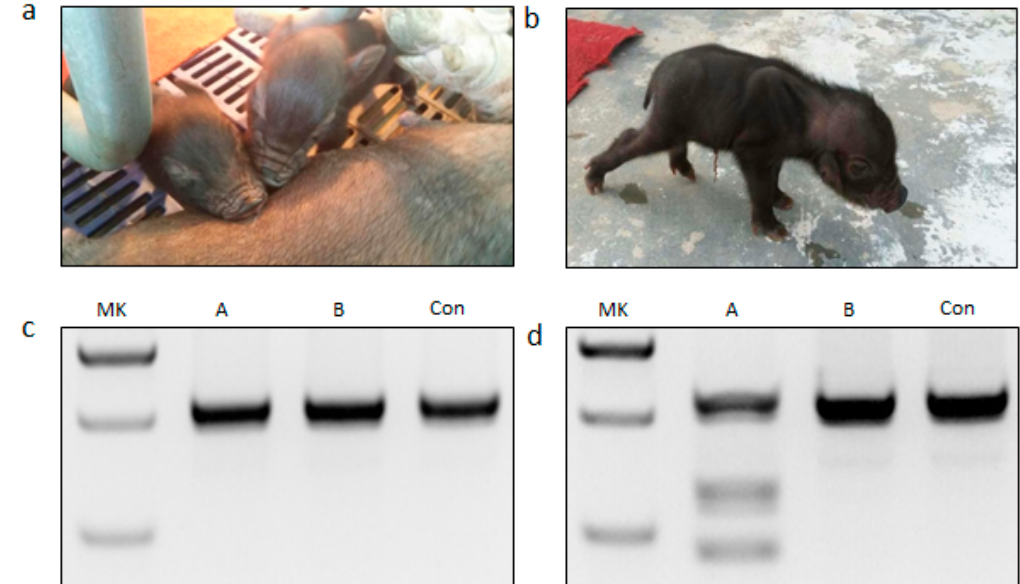
Figure 2. Detection of DMD sgRNA:Cas9-mediated modifications of DMD in funicle tissues of founder pigs. ( a ) Photograph of newborn founders; ( b ) DMD -modified founder A; ( c ) PCR products of the DMD targeted region amplified from founder pigs. MK, DNA marker; A, founder A; B, founder B; Con, PCR product of targeted region amplified from wild-type pig; ( d ) Detection of sgRNA:Cas9-mediated on-target cleavage of DMD by the T7EN1 cleavage assay in founder pigs. Con, PCR product of targeted region amplified from wild-type pig, digested by T7EN1.